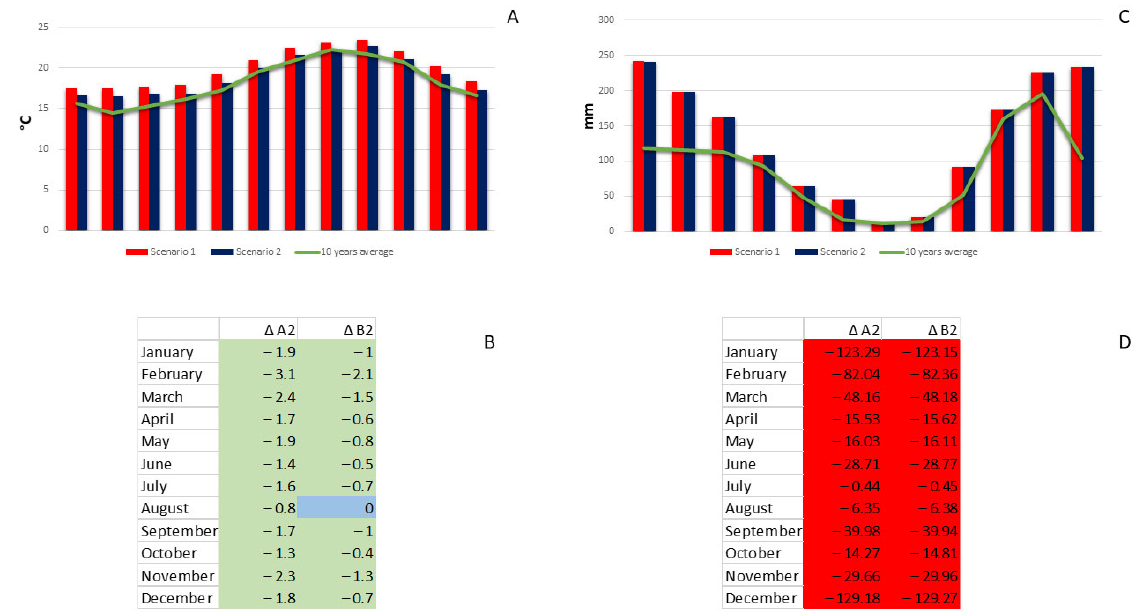
Figure 4. Comparison of recent series average ( A ) temperature and ( C ) accumulated precipitation (green line) with simulated ones for 2070–2099 scenarios ∆ A2 red and ∆ B2 blue columns. Difference between simulated average temperature and accumulated precipitation for the two scenarios ( ∆ A2 and ∆ B2), with recent series of temperature and accumulated precipitation (Figure 4B and Figure 4D respectively).